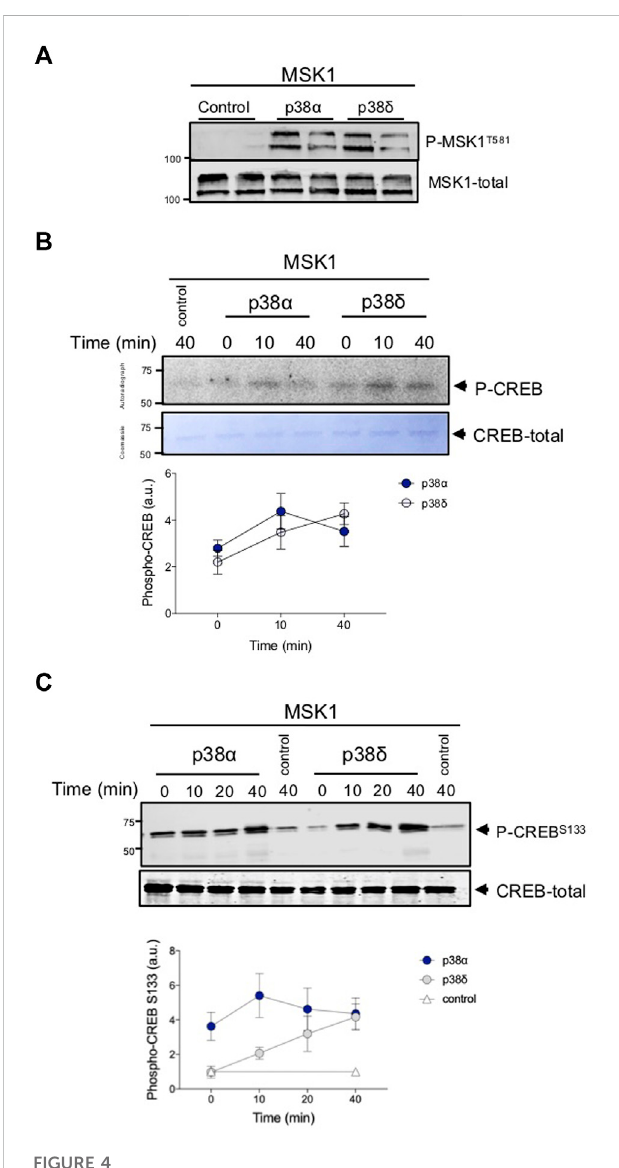
FIGURE 4 MSK1 is activated by p38 δ . (A) Recombinant GST-MSK1 (100 ng) was incubated with active recombinant p38 δ (0.5 U/mL) for 60 min at 30 ° C in a phosphorylation reaction mix as described in materials and methods. Reaction was stopped with SDS-sample buffer and samples immunoblotted with the indicated